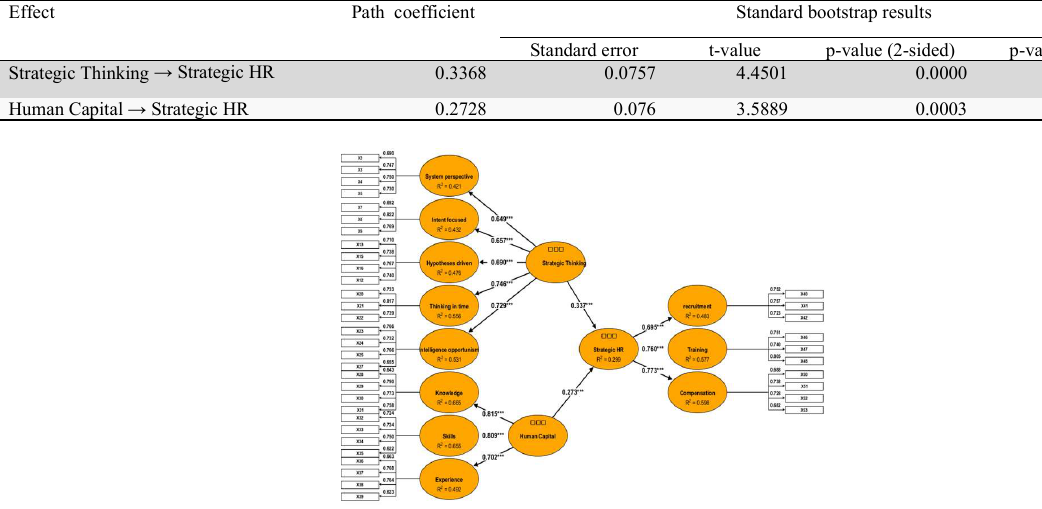
The results of the first model using PLS bootstrapping procedures